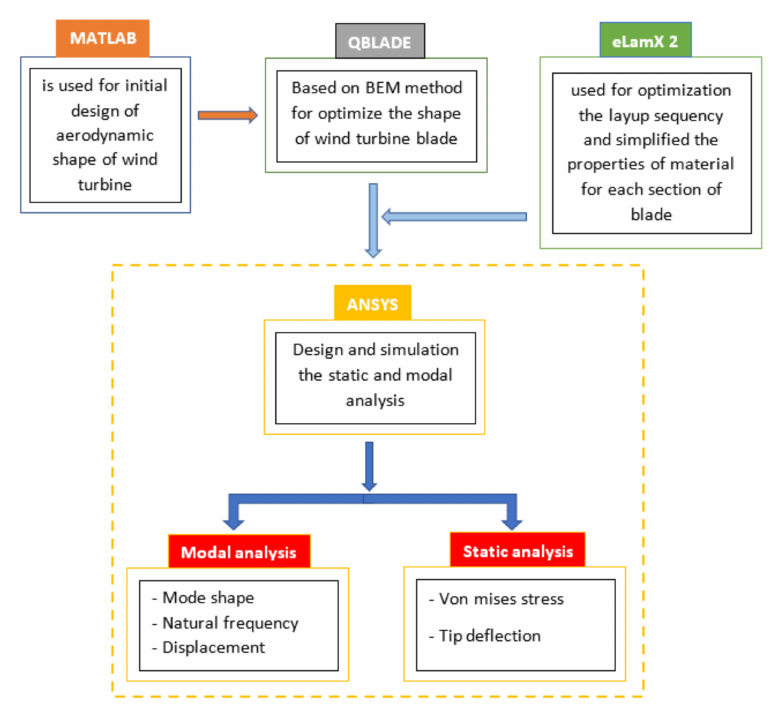
Figure 1. The main steps to optimize small wind